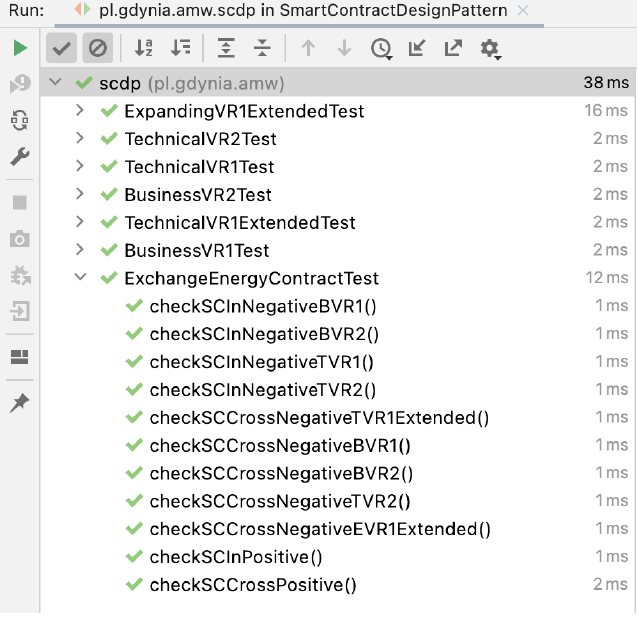
Figure 6. Test results for the ExchangeEnergyContractTest